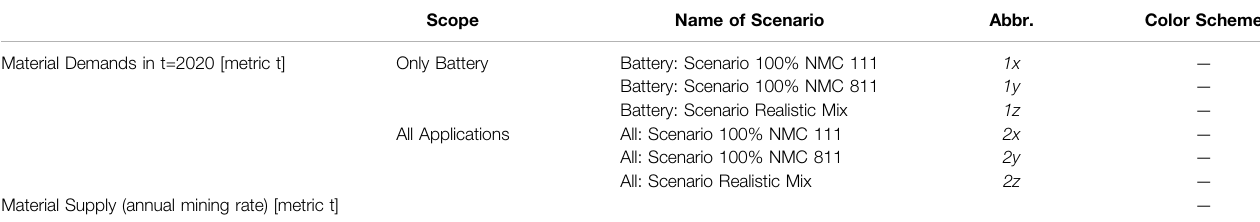
Table 4 | Material demand scenarios.